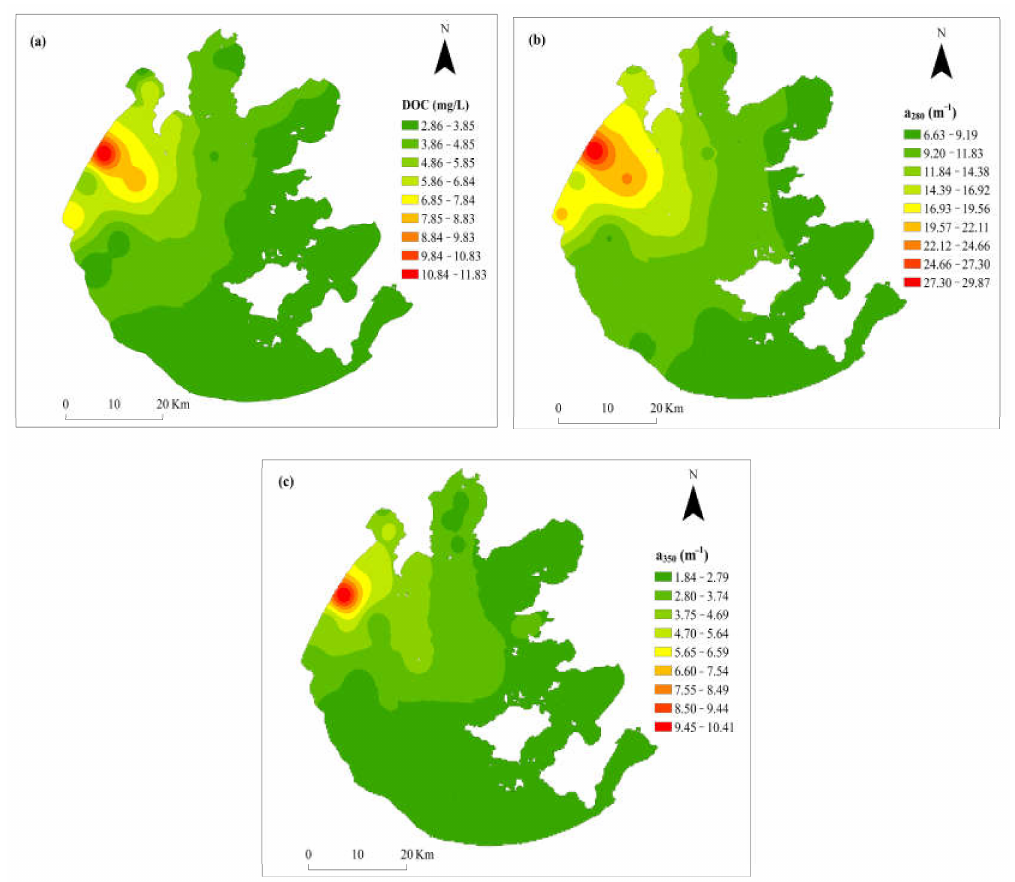
Figure 2. Spatial distributions of dissolved organic matter (DOM) and colored dissolved organic matter (CDOM; a 280, a 350 ) in the overlying water of Lake Taihu. ( a ) DOC; ( b ) a 280 ; ( c ) a